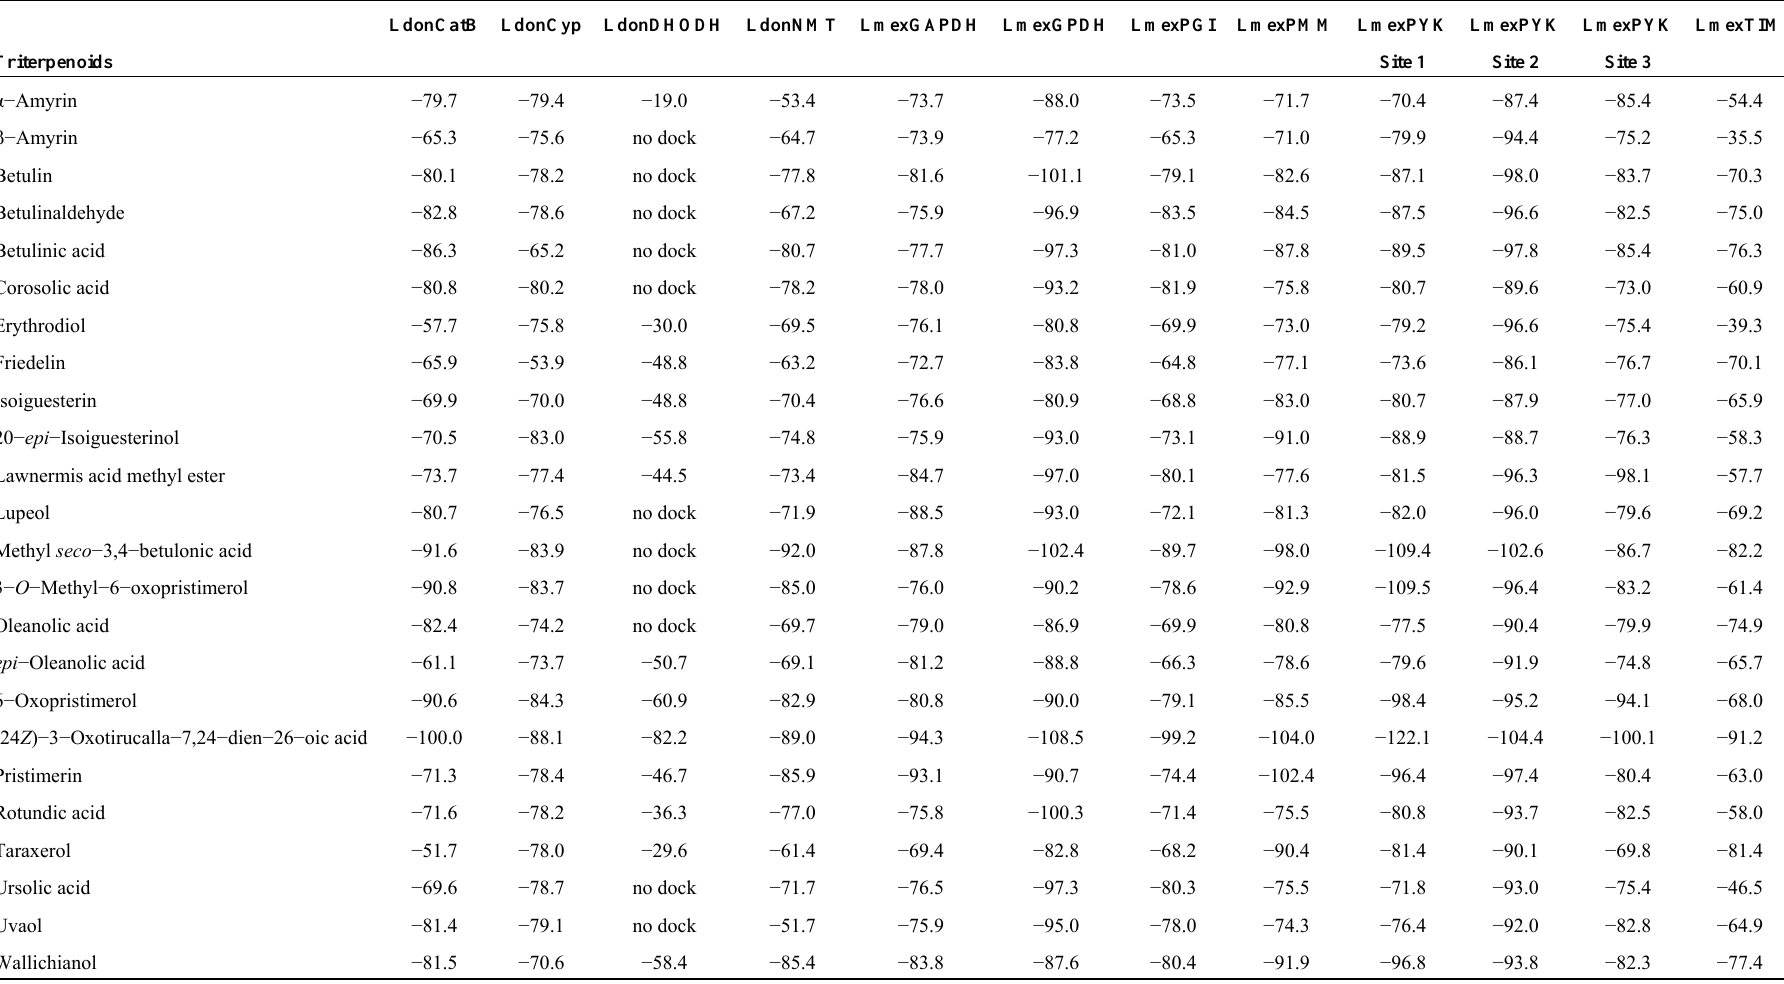
Table 36. MolDock docking energies (kJ/mol) of triterpenoids with Leishmania donovani and L. mexicana protein